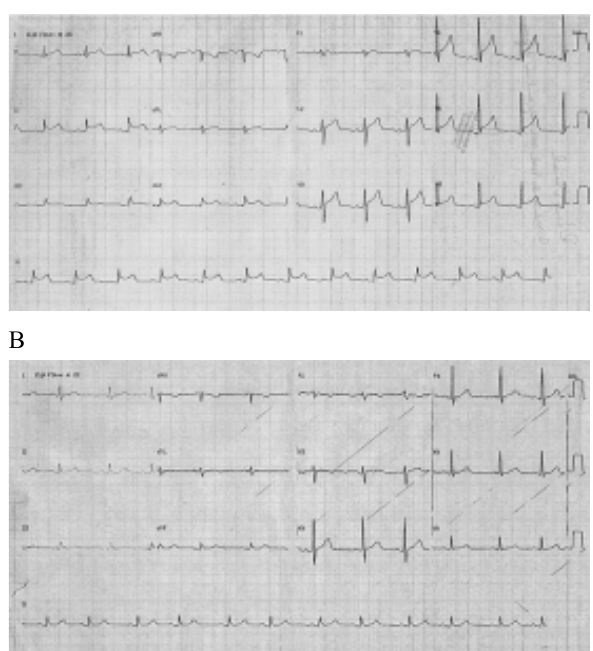
Fig. 1 – A: Eletrocardiograma realizado durante o atendimento na emergência hospitalar em julho de 2001, quando o paciente relatava dor precordial e retroesternal com duração de 04 dias, mostra supradesnivelamento do segmento ST nas derivações II, III e a VF (parede inferior) e alterações inespecíficas do segmento ST em outras derivações. B: Eletrocardiograma realizado minutos após uso de nitrato sublingual mostra melhora do supradesnivelamento do segmento ST nas derivações descritas acima